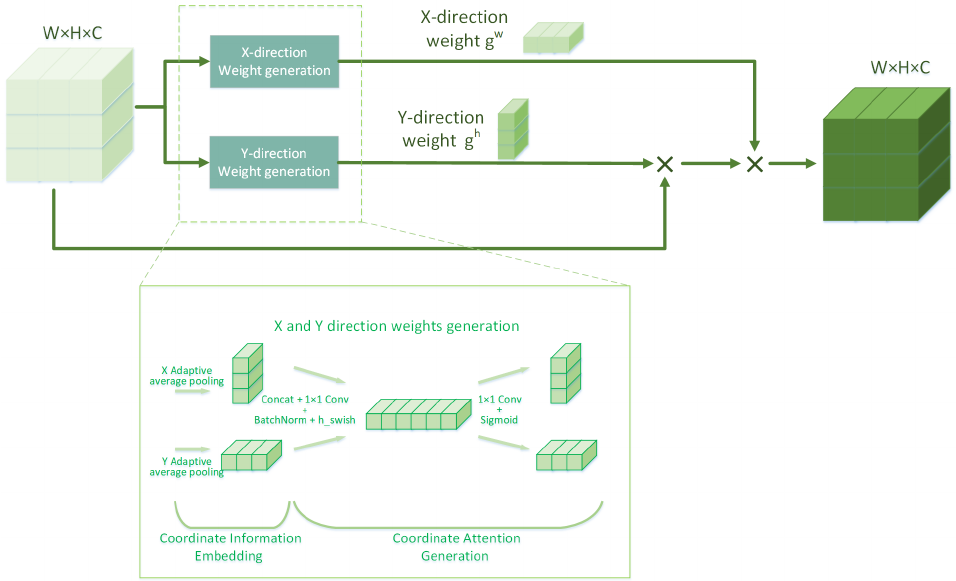
Figure 3. The architecture of the coordinate